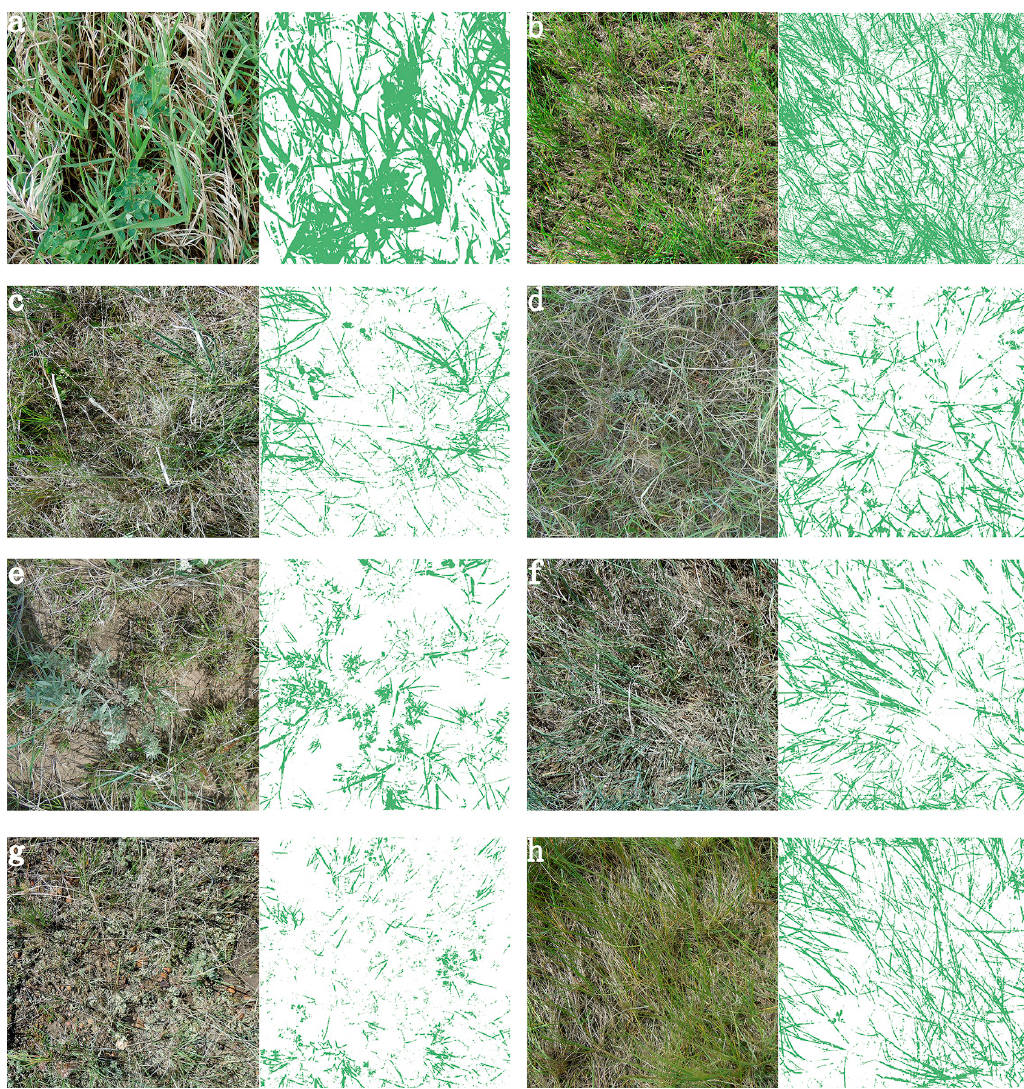
Figure 7. Extracted green vegetation from RGB images. ( a ) RGB image taken in disturbed communities; extraction of green vegetation (GV) with g 1 = 60 and g 2 = 60. ( b ) RGB image taken in upland grassland; extraction of GV with g 1 = 60 and g 2 = 60. ( c ) RGB image taken in valley grassland; extraction of GV with g 1 = 60 and g 2 = 60. ( d ) RGB image taken in sloped grassland; extraction of GV with g 1 = 60 and g 2 = 60. ( e,f ) RGB image taken in valley grassland; extraction of GV with g 1 = 40 and g 2 = 32. ( g ) RGB image taken in sloped grassland; extraction of GV with g 1 = 60 and g 2 = 40. ( h ) RGB image taken in upland grassland; extraction of GV with g 1 = 30 and g 2 = 60.